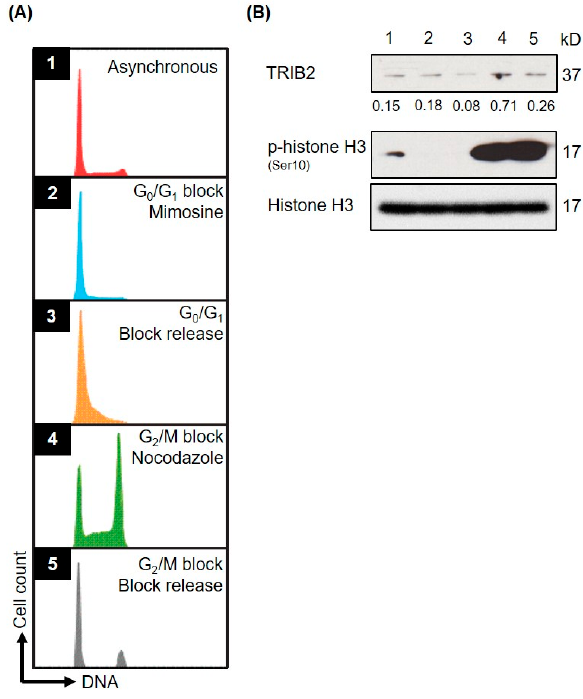
Figure 4. TRIB2 is regulated at the protein level at cell cycle specific phases. Asynchronous (1) SB1690CB cells were G0/G1 (2) arrested by Mimosine followed by release to allow them to progress into S cell cycle phase (3) synchronously and G2/M (4) arrested by Nocodozole followed by release to allow M phase (5) progression. ( A ) Histogram representation of cell cycle analysis by flow cytometry; ( B ) Western blotting analysis with TRIB2 and p-histone H3 signal serves as a mitosis marker. Histone H3 indicated protein loading. TRIB2 signals were quantified by densitometry analyses and normalized to the respective Histone H3 signals. The normalized values were indicated below the sub-panel.